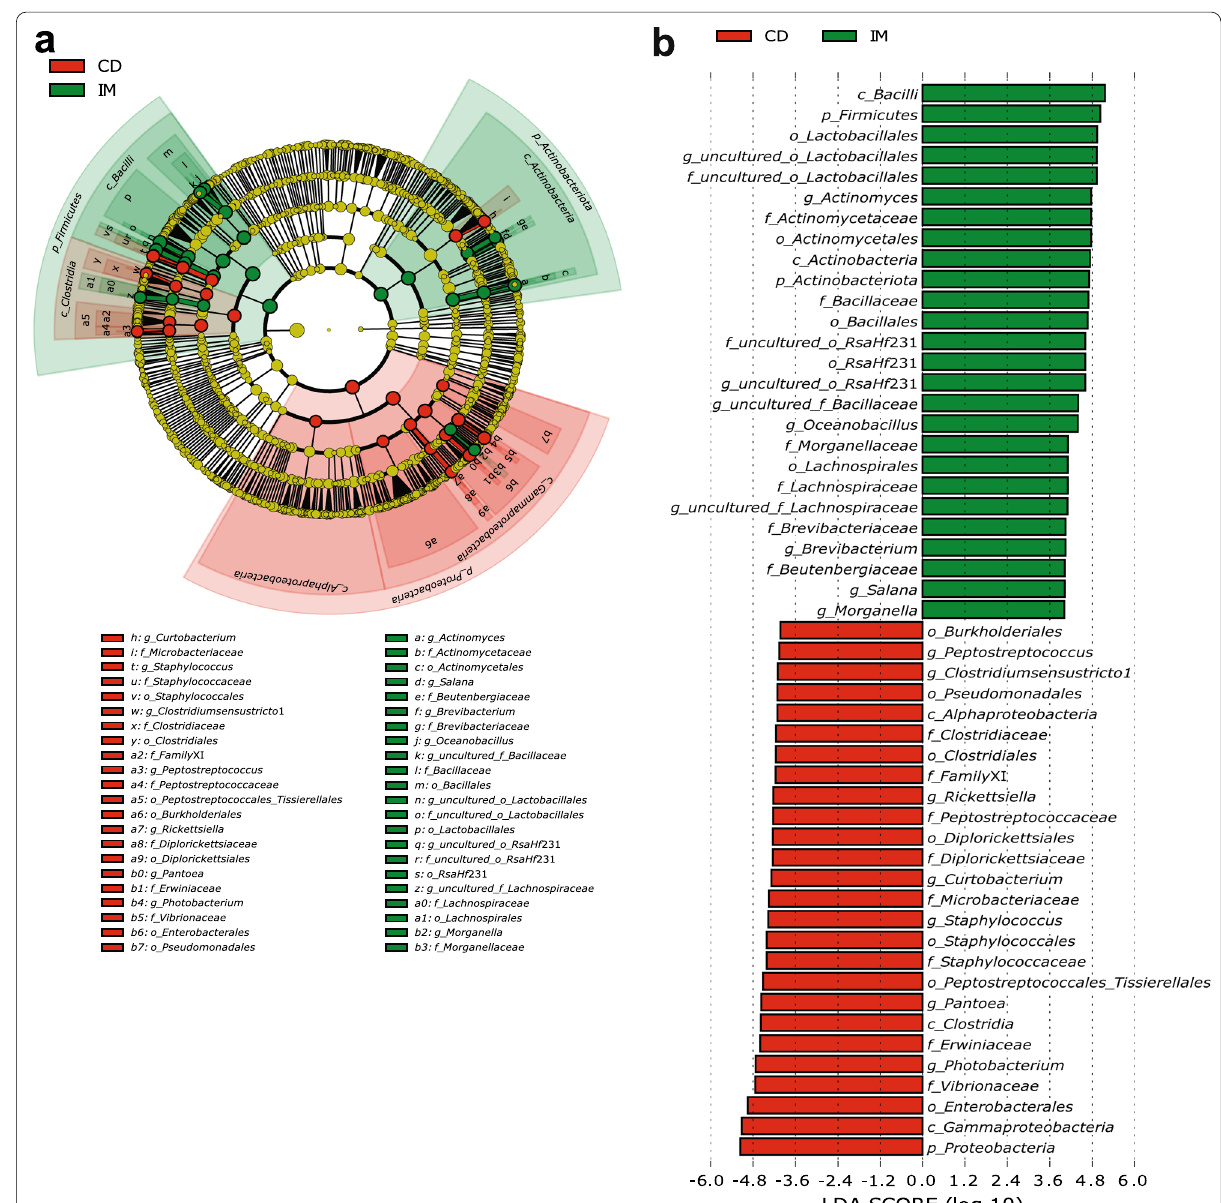
Fig. 4 Linear discriminant analysis (LDA) effect size (LEfSe) results on gut microbiota of fish fed CD and IM diets. Circular cladogram reporting LEfSe results presents the identified amplicon sequence variants (ASVs) distributed according to phylogenetic characteristics around the circle ( a ). The dots closest to the center represent ASVs at the phylum level, whereas the outer circle of dots represent ASVs at the genus level. The color of the dots and sectors indicate the dietary group in which the respective ASVs are most abundant. The color explanation is given in the upper left corner. Yellow color indicates ASVs that showed similar abundance in all dietary groups. The colored sectors give information on phylum, class (full name in outermost circles, given only for phylum or class showing significant difference between groups), order, family, and genus (indicated by letter). The explanation is given below the cladogram. Indicator taxa with LDA scores of 4 or greater in the microbial communities ( b ). p phylum; c class; o order; f family; g genus; CD control diet; IM full-fat black soldier fly larvae meal